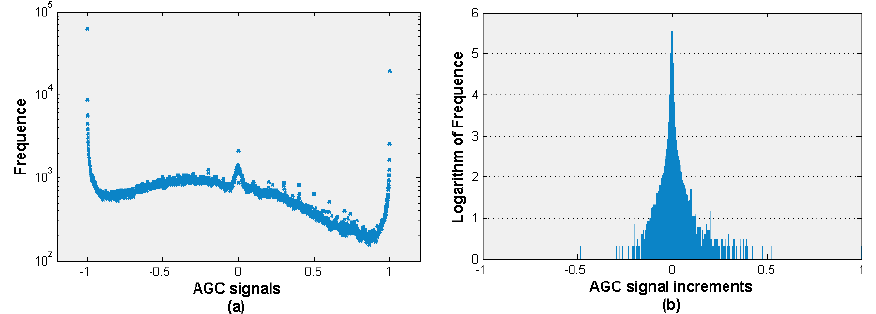
( b ) the logarithm of frequency of automatic generation control (AGC) signal increments with